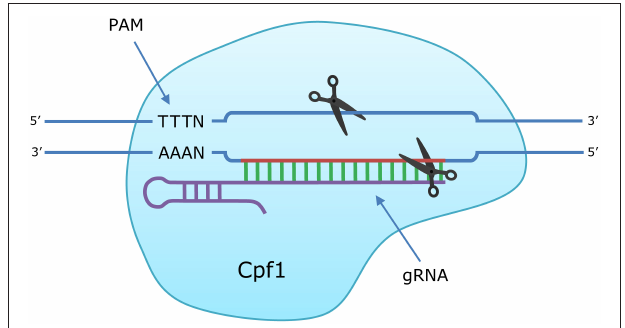
FIGURE 1 | Introduction of a double stranded break (DSB) in DNA by CRISPR/Cas12a (Cpf1). The guide RNA (gRNA) directs the Cas12a endonuclease to the homologous target sequence. When the protospacer-adjacent motif (PAM) is recognized and the crRNA hybridizes with the target sequence, the nuclease domains of Cas12a introduce breaks in each strand: 19 nt (target strand) and 23 nt (complementary strand) downstream from the PAM